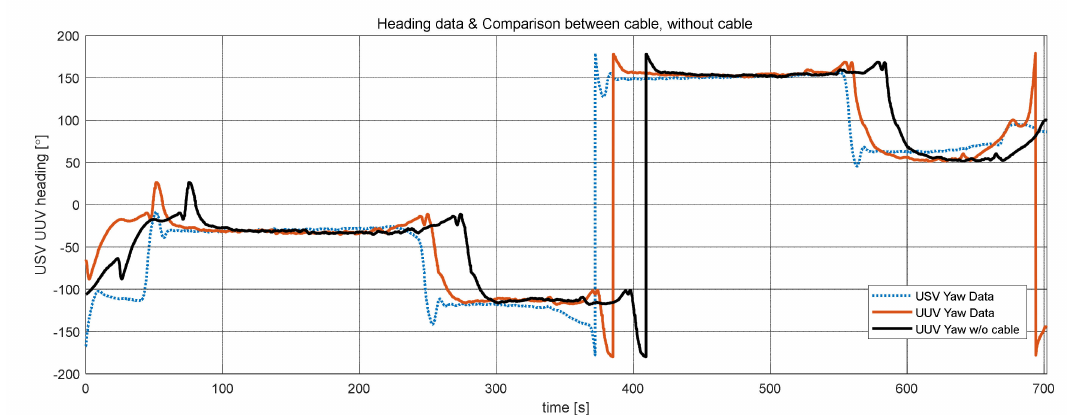
Figure 27. Heading data of USV and UUV during waypoint tracking and simulated result of the non-cabled collaborating